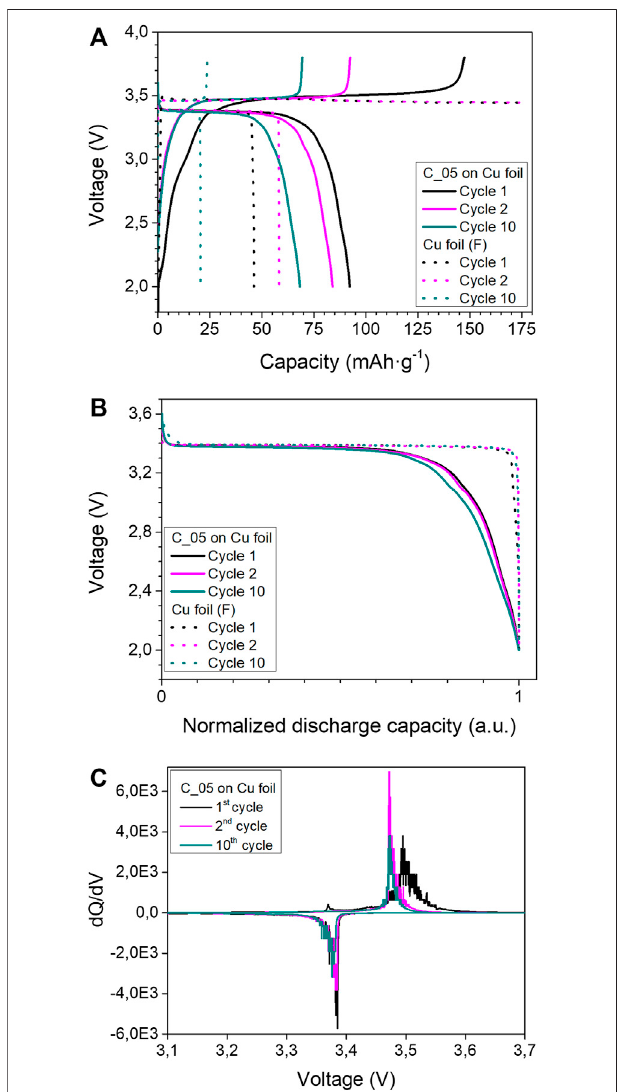
FIGURE4| Electrochemicalcharacterizationofanode-freecellswiththe best coating (C_05) on Cu foil, and bare Cu foil asthe anode current collector. (A) Charge/discharge pro fi les, (B) normalized discharge capacity of the fi rst, second, and 10th cycles. (C) Differential capacity plots (dQ/dV) corresponding to the voltage pro fi les of the “ C_05 ” based cell. Cycling conditions: 60 ° C, 1 N m, DoD 100%, 2.5 – 3.8 V, 0.1C – 0.1C, and charge cut off current